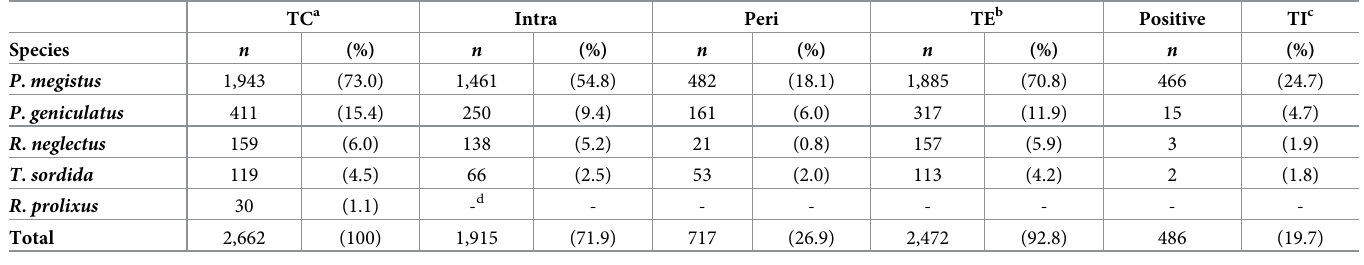
Table 1. Infection rates for Trypanosoma cruzi of synanthropic triatomines captured from 2007 to 2013 in the State of